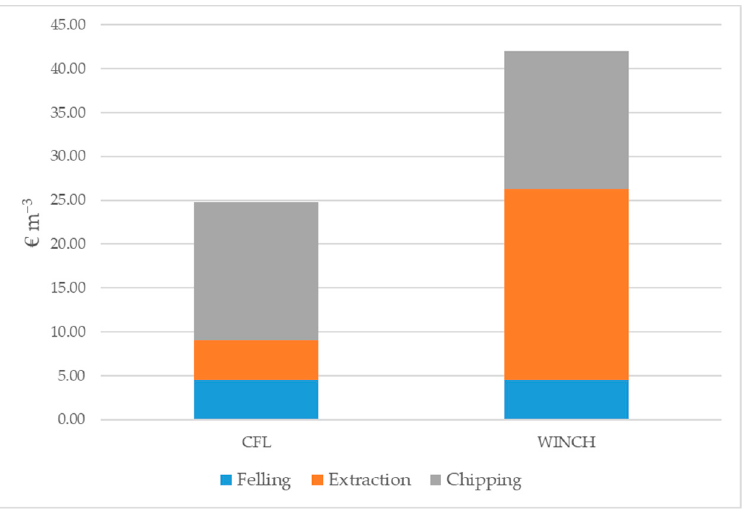
Figure 3. Costs of the two investigated harvesting systems.